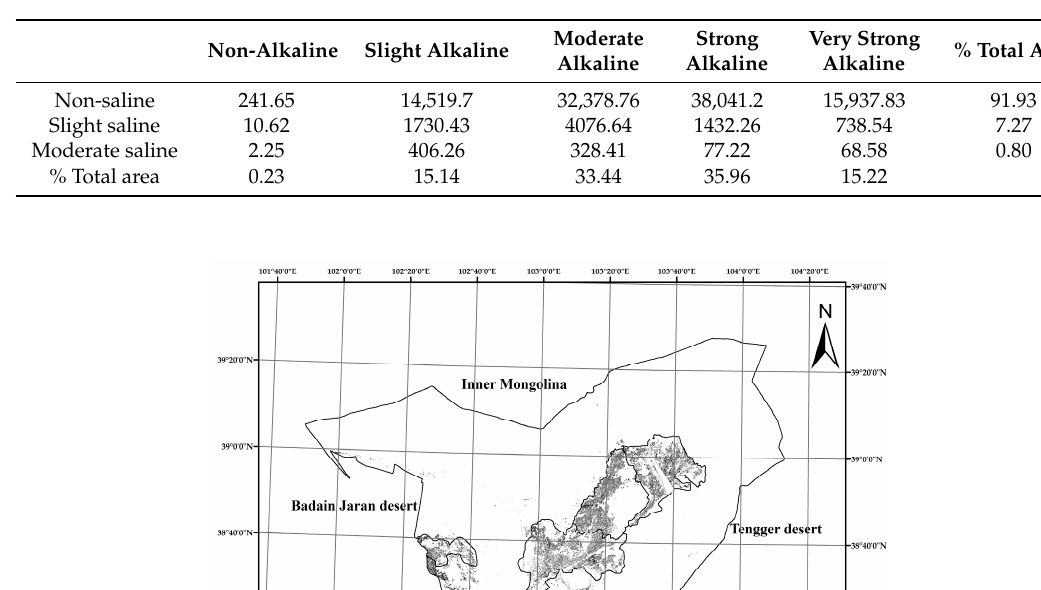
Table 8. The concurrent area of agricultural soil salinity and alkalinity class in the root zone